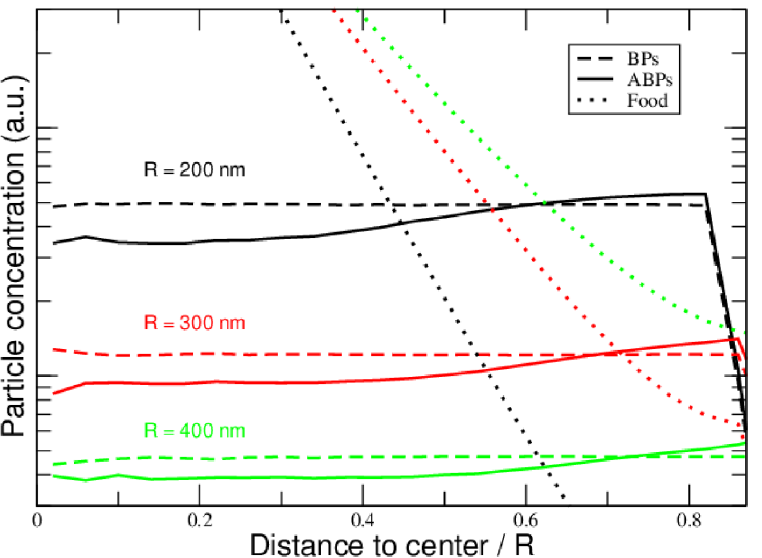
Fig 2. Particle densities in a stationary system. Particle concentration as a function of (relative) distance to the center, for different sizes R of the reactor. Different colors stand for different radii of the containers (black: 200nm; red: 300nm; green: 400nm). Close to the food source, ABPs are active most of the time, leading to a significant depletion of their concentration. Close to the outer wall (right edge of the graphic), particle concentrations drop due to steric repulsion. Food-production rate: 50/ μ s; number of particles: 100 (of each species, ABPs and BPs); simulation time: 2s; ¼ 2 t � 18 m s . boost time of ABPs: t B r